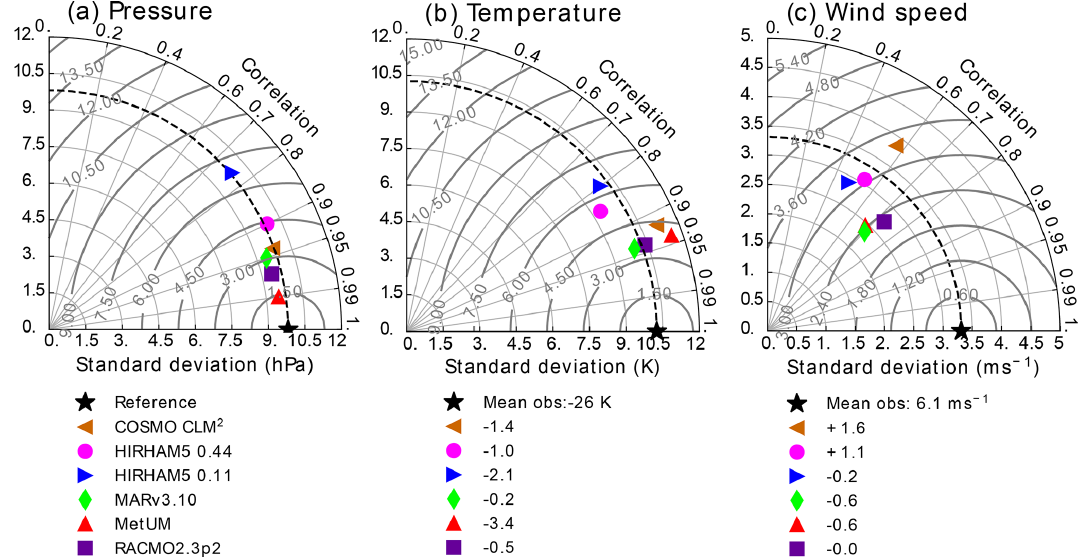
Figure 1. Taylor diagrams showing model performance compared to daily observations of surface pressure (a) , near-surface temperature (b) , and observed wind speeds (c) . The horizontal and vertical axes represent the standard deviation; the dashed line in bold shows the standard deviation of the observations. The Taylor plot also shows the correlation which is measured by the angle with the x axis. Finally, the CRMSE is represented by the curved lines in light grey. The units of standard deviation, CRMSE, mean bias, and mean of the observations are the same (hPa for surface pressure, K for near-surface temperature, and ms − 1 for wind speed).